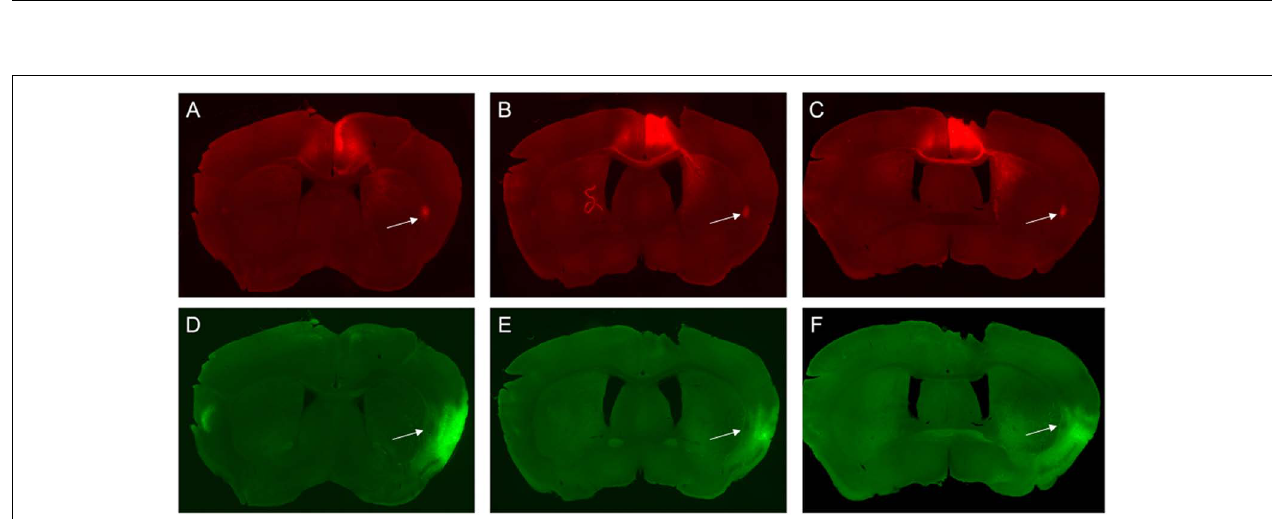
FIGURE 3 | Photomicrographs of the claustrum and surrounding regions at three different rostrocaudal levels of claustrum (CL). Case B2.2 AP = + 1.10 mm to + 0.14 mm relative to bregma shown. The distribution of labeled elements on the ipsilateral side of viral injection in ACC is shown at rostral (A) to mid ( B ) to caudal levels (C ). The distribution of labeled elements resulting from viral tracer injection into the aINS is shown in the same sections (D–F) . Arrows point to claustrum.